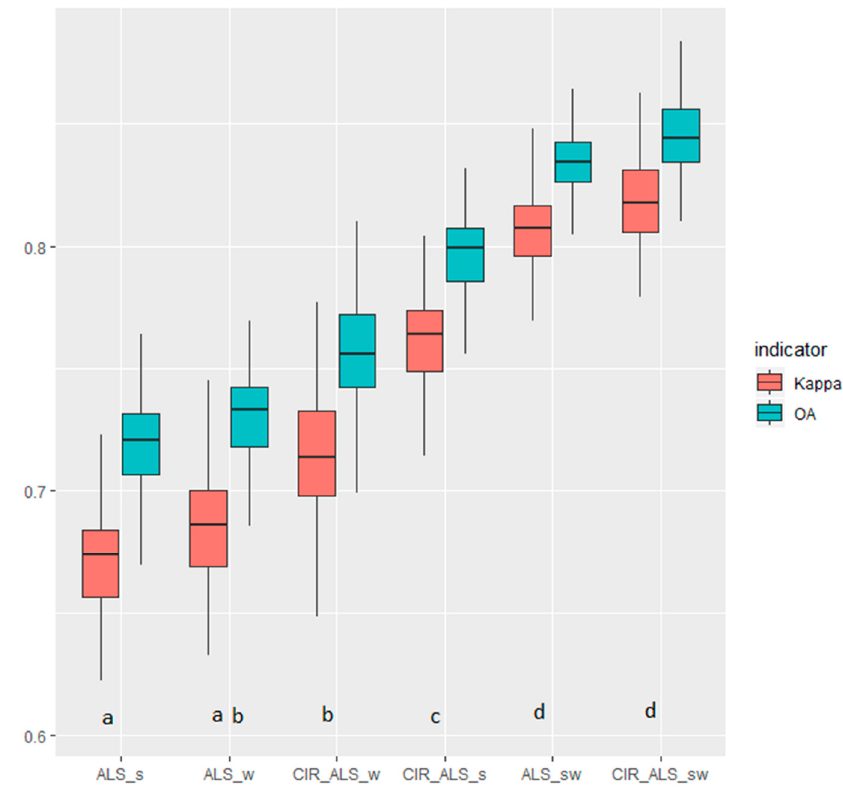
Figure 4. Box-and-whisker plots of accuracies for different classification variants based on both point clouds and CIR. The first and third quartiles define the box, the median is shown as “—”, and the whisker defines the range of the data without outliers. Letters ‘a, b, c, d’ identify homogenous groups with no significant differences (based on McNemar’s test). The ALS is the point cloud from the leaf-on (S) or/and leaf-off (W) season, whereas the CIR is the spectral information derived from the colour-infrared images.